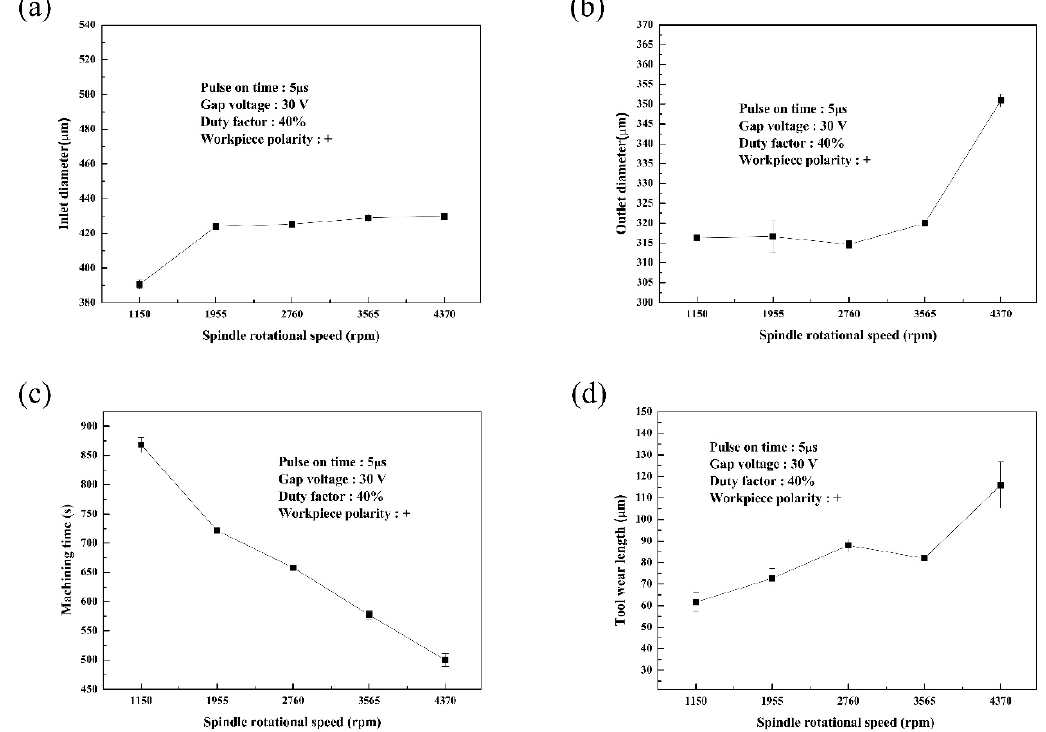
Figure 10. The relationship between spindle rotational speed and ( a ) inlet diameter, ( b ) outlet diameter, and ( c ) machining time. ( d ) Length of electrode wear.